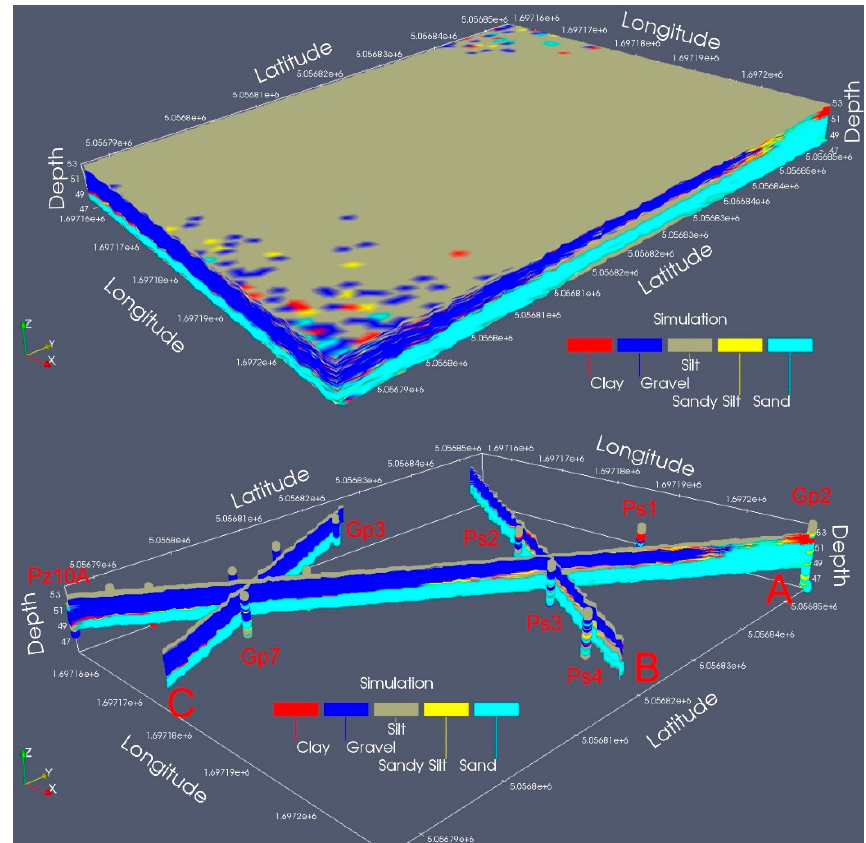
Figure 6. Markovian-type Categorical Prediction (MCP) 3D simulation on 91 layers every 5 cm in depth from 53 to 48.5 m a.s.l.; cross sections A, B, C of MCP 3D simulation and simplified stratigraphies of the 13 boreholes.